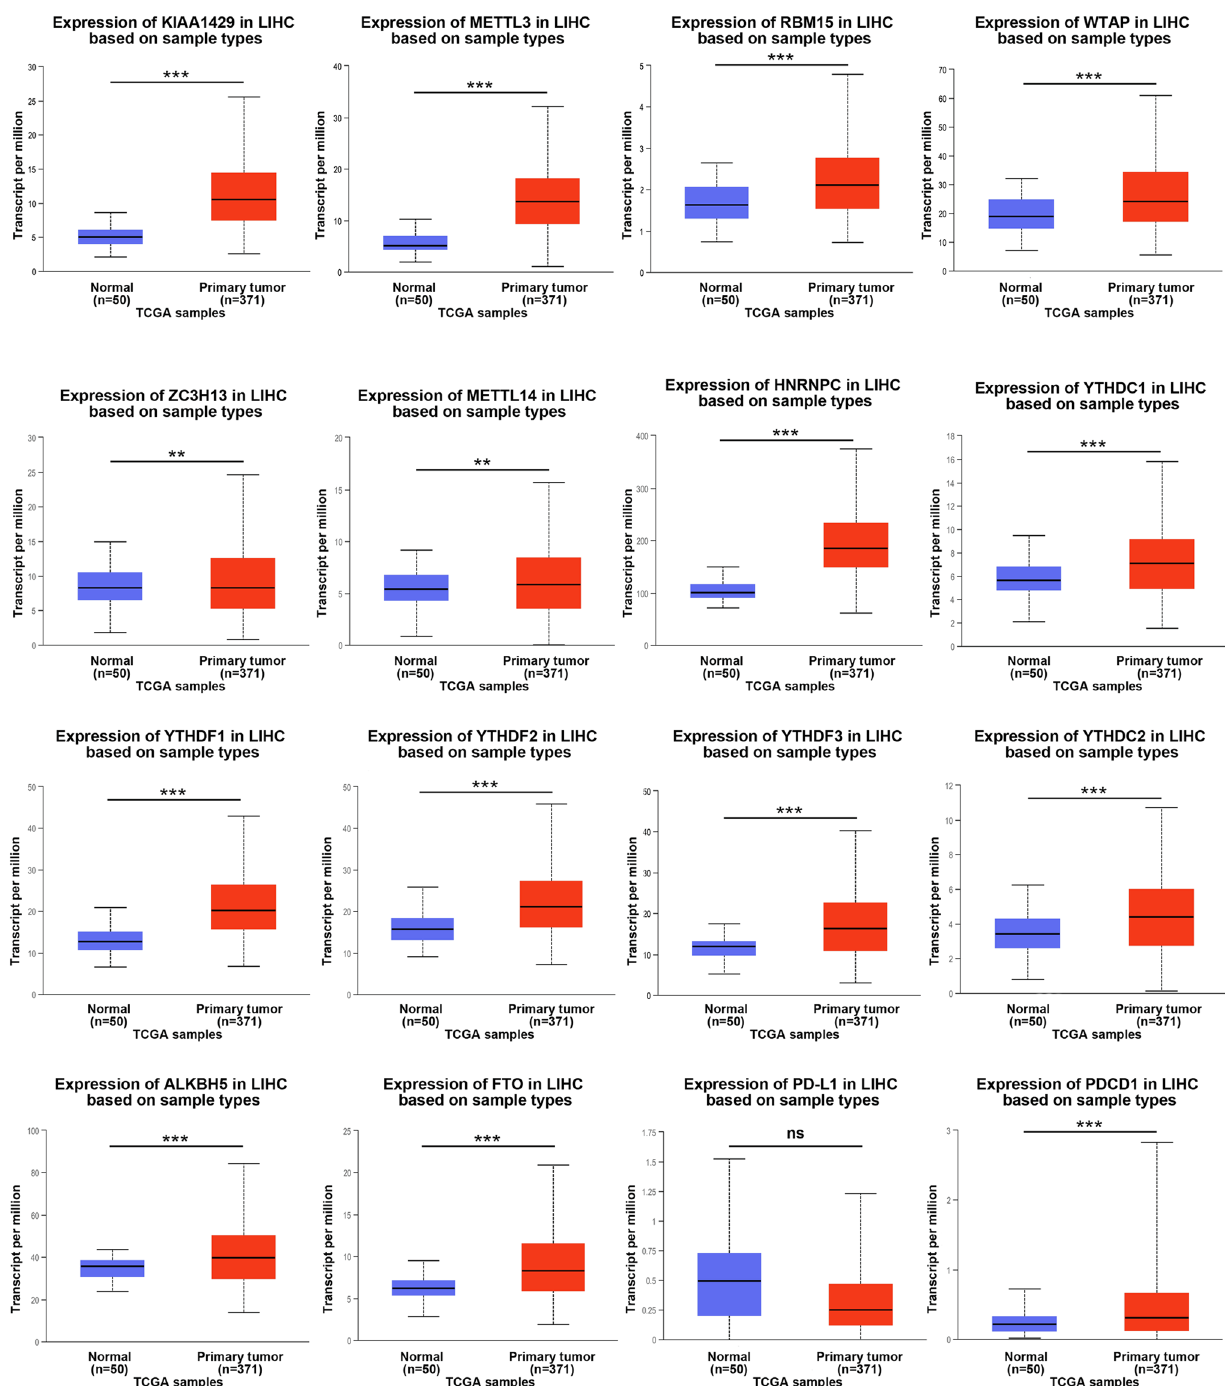
Fig. 1 mRNA expression of m6A regulators in HCC tumor tissues and adjacent liver tissues. Compared with normal liver tissues, the expres- sion of m6A regulators in HCC tissues was higher than that in normal liver tissues. ***p < 0.001, **p <